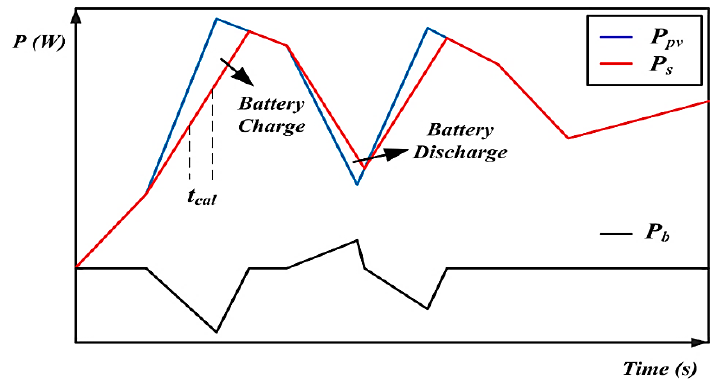
Figure 4. Charge and discharge characteristics of a battery using ramp-limit control.